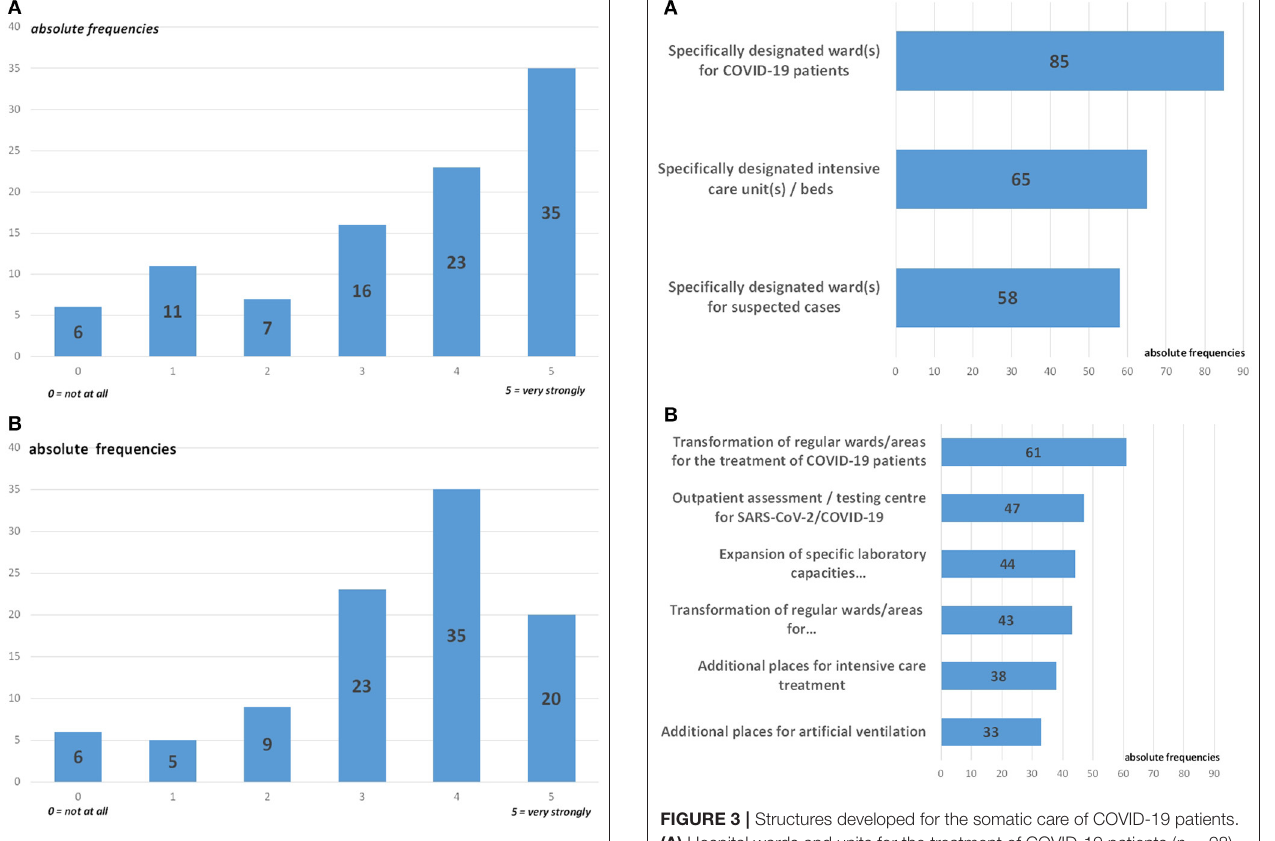
FIGURE 2 | Involvement in the somatic care of COVID-19 patients. (A) Maximum level of involvement of the hospitals ( n = 98) in the somatic care of COVID-19 patients since the beginning of the pandemic. (B) Extent the hospitals ( n = 98) were maximally occupied regarding the somatic care of COVID-19 patients.